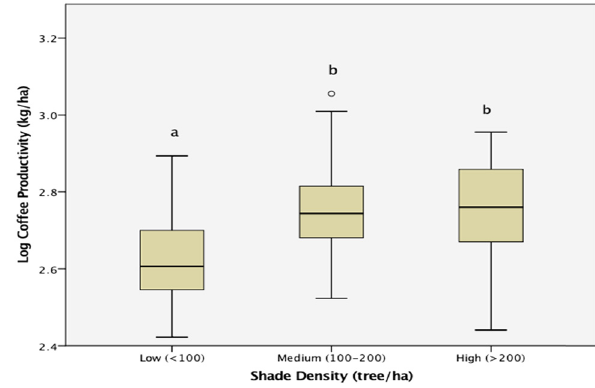
Figure 3: The e ff ect of shade density on log co ff ee productivity; general linear model ( P < 0.000 ) ; means followed by the same letter did not di ff er ( LSD P < 0.05 )